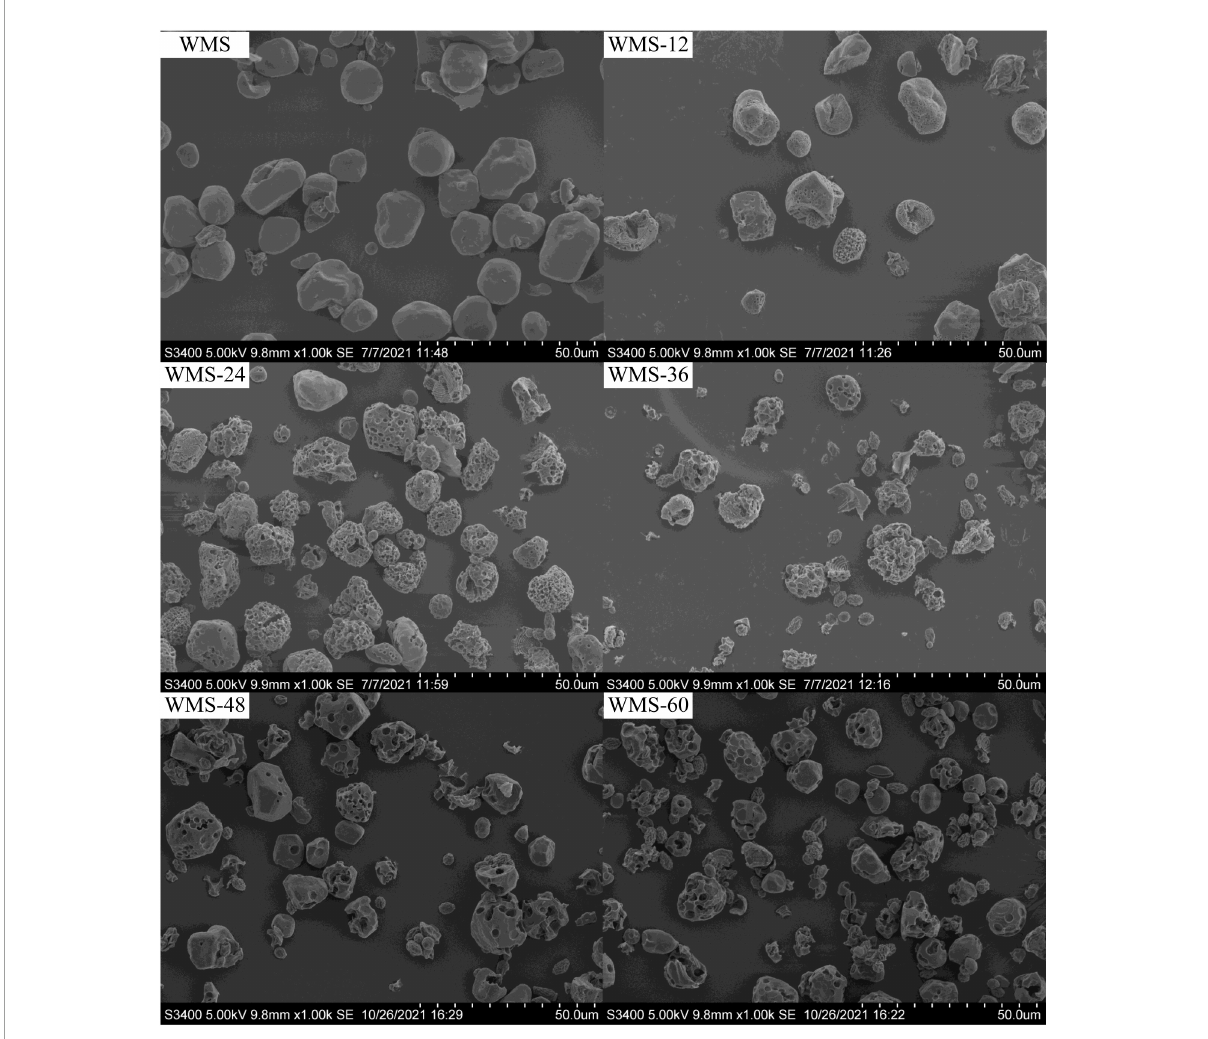
FIGURE1 Scanning electron microscopy images showing the morphology of native starch and fermented starch. WMS, native waxy maize starch fermented for x h.